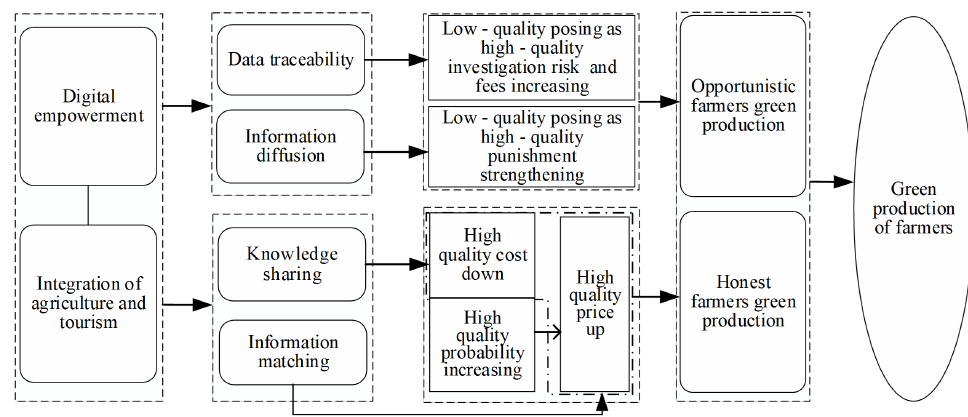
Figure 3. The mechanism chart of farmer’s green